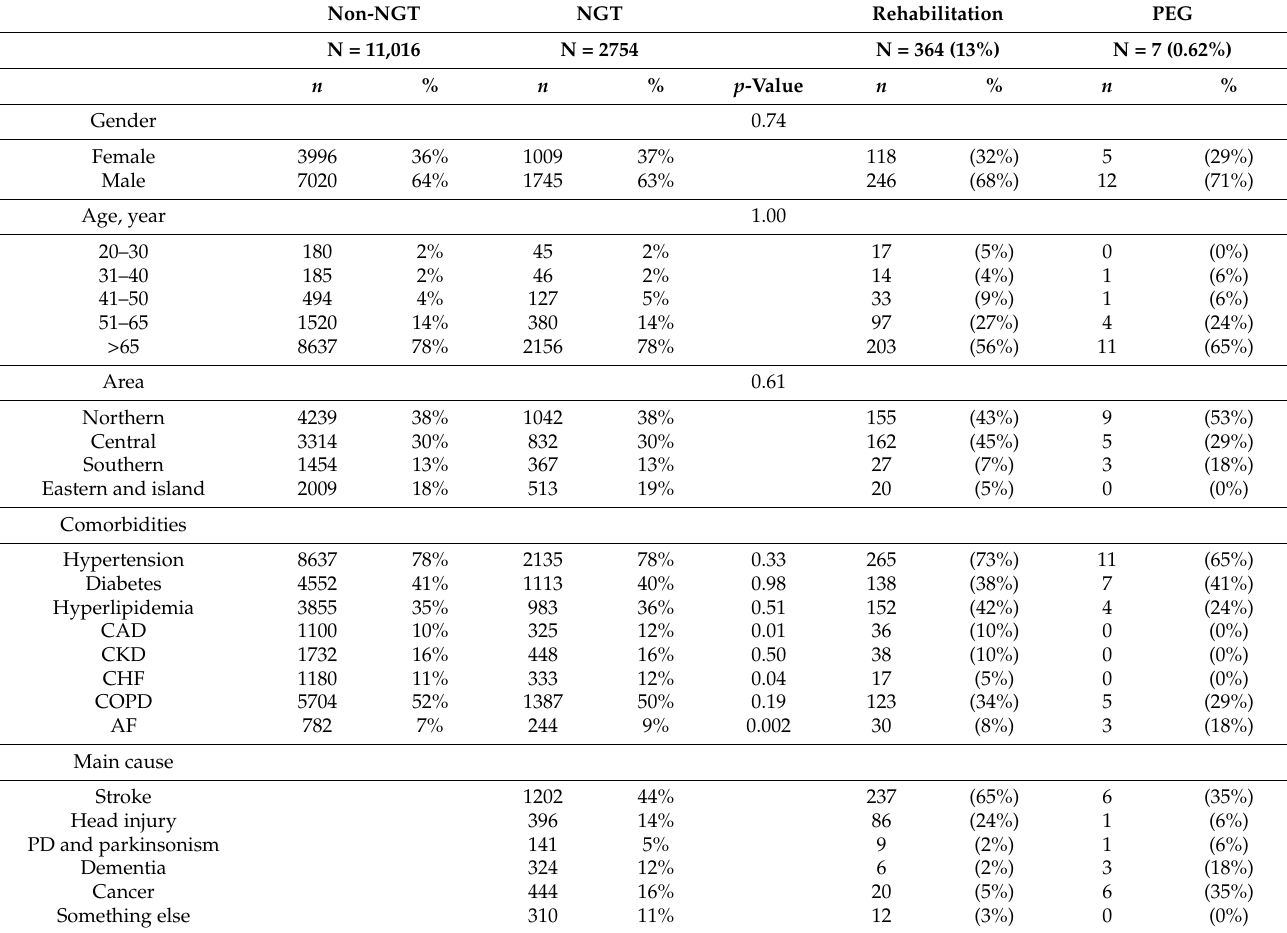
Table 2. The baseline characteristics of patients with and without nasogastric tube